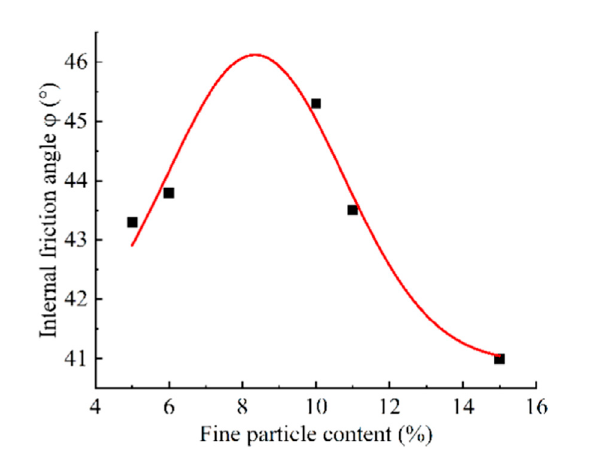
FIGURE 11 Fitted relationship curve between the fi ne particle content and internal friction angle.